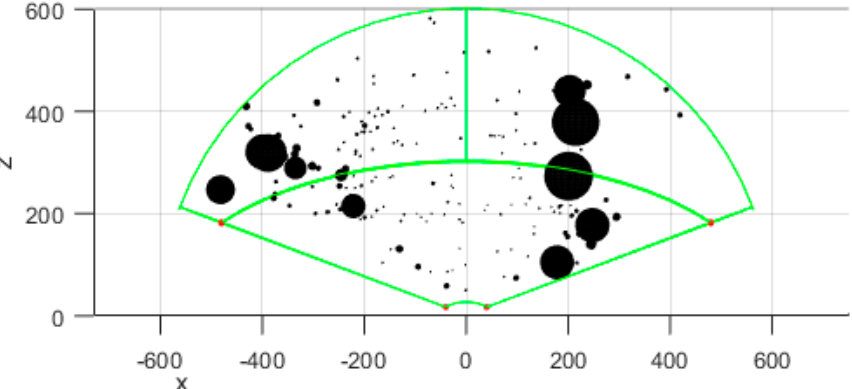
Figure 7. Up to 60 cm: front–back view. X and z axis are in mm.